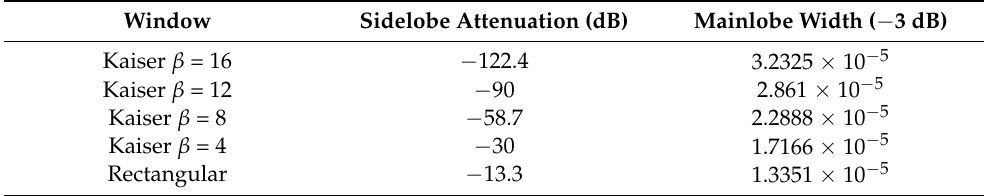
Table 2. Listing of key window function